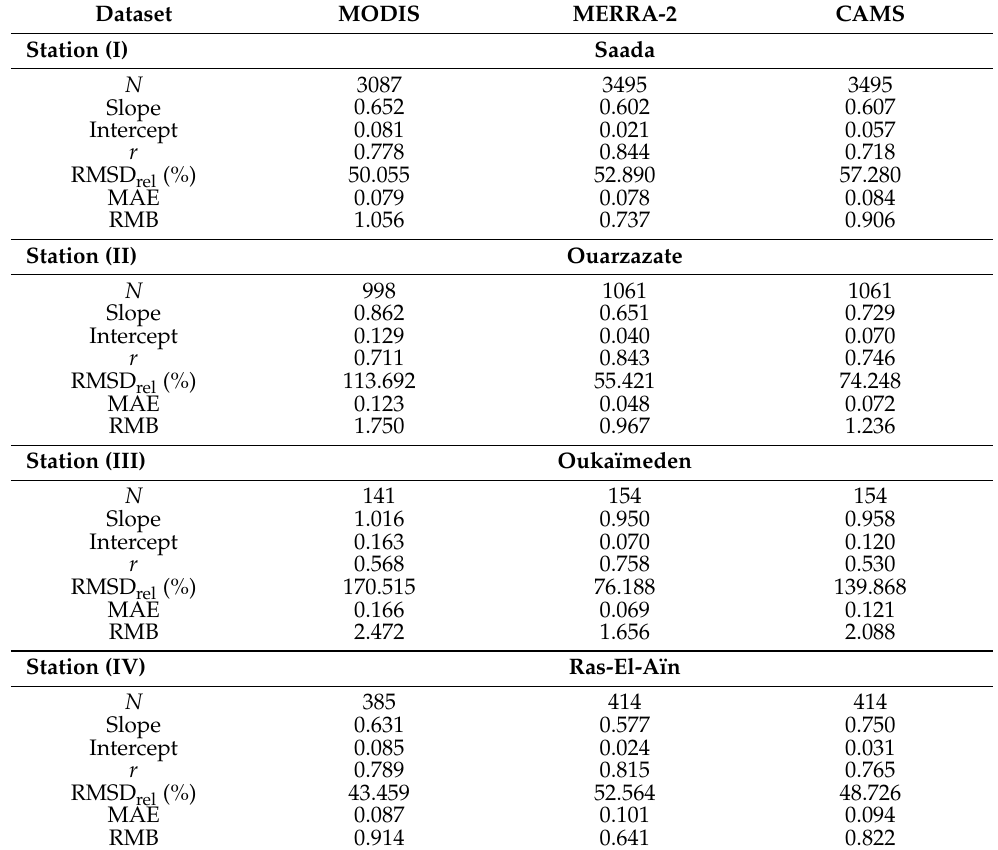
Table A1. Statistical results of the comparison between MODIS, MERRA-2, CAMS and AERONET